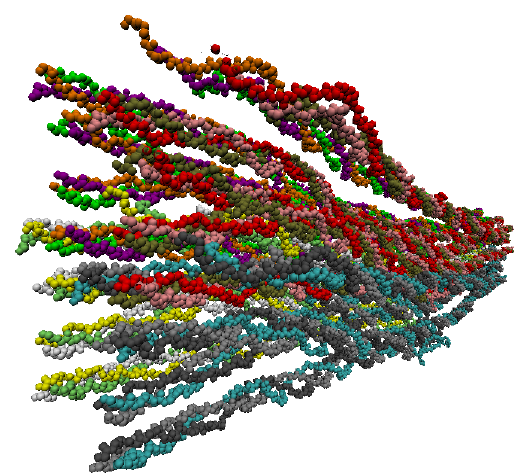
Figure A5. Devised CLG Fiber shown in VMD. The CLG chains (three chains each in one color) of a previous specific CLG NanoFiber are all represented five times (in the overlap zone) by the same three colors, e.g., five CLG molecules with their three chains in gray, cyan, and black. The different replications of the previous CLG NanoFiber can be identified by the colors cyan, red, yellow, and